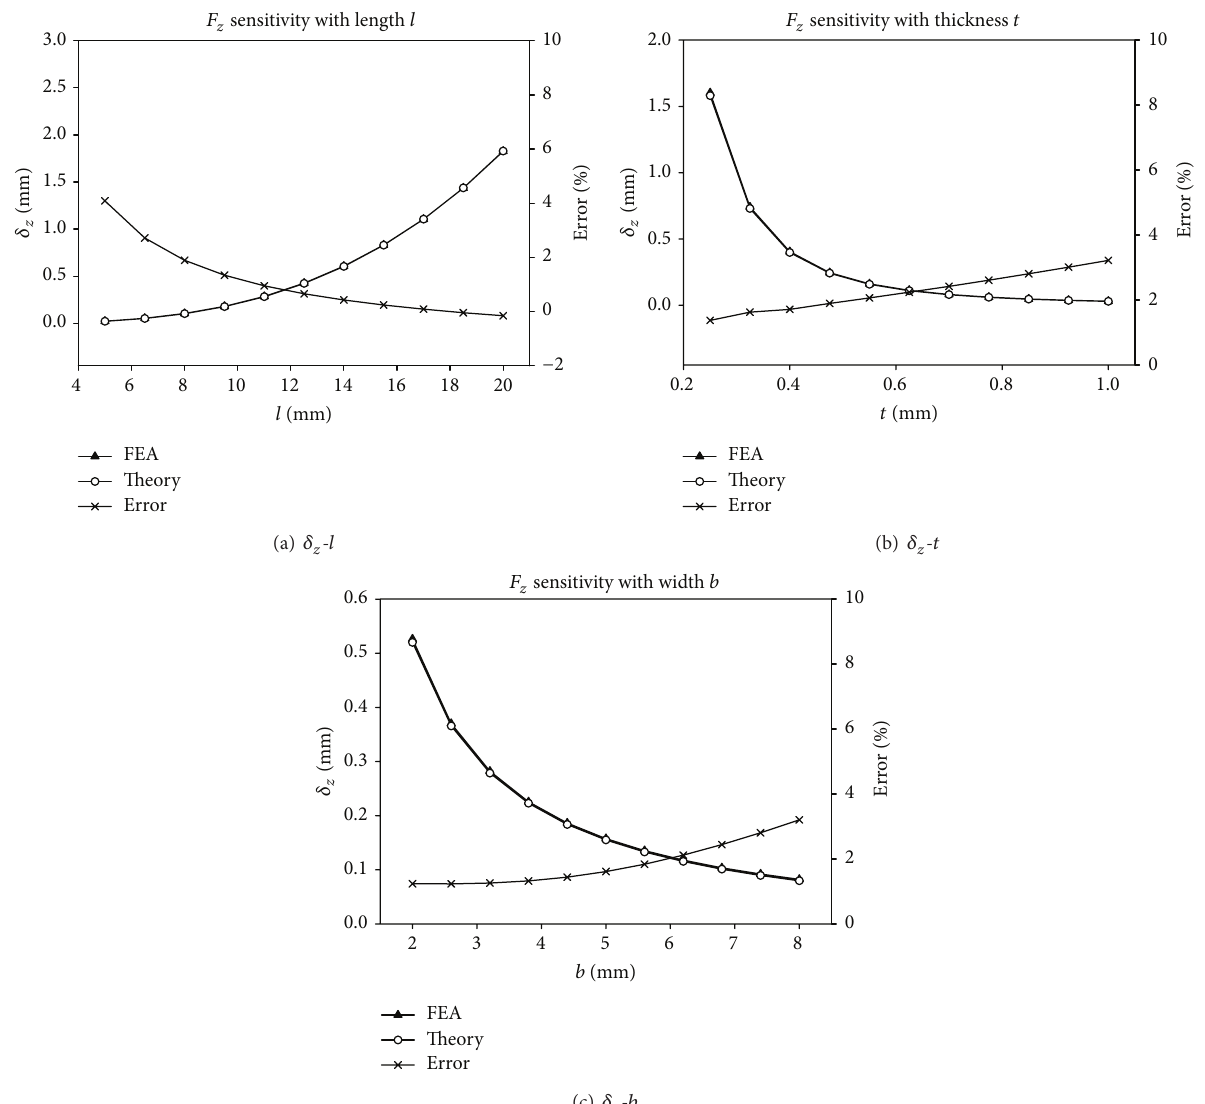
Figure 3: Variation of deflection 𝛿 𝑧 according to (a) length 𝑙 , (b) thickness 𝑡 , and (c) width 𝑏 under 𝐹 𝑧 .